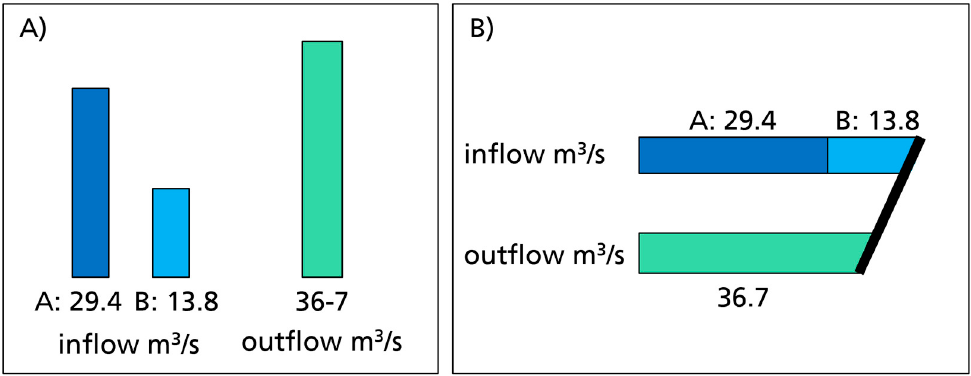
Figure 1. Example of a single-sensor single-indicator visualization ( A ) and a visualization with emergent features ( B emergent features ( B ).